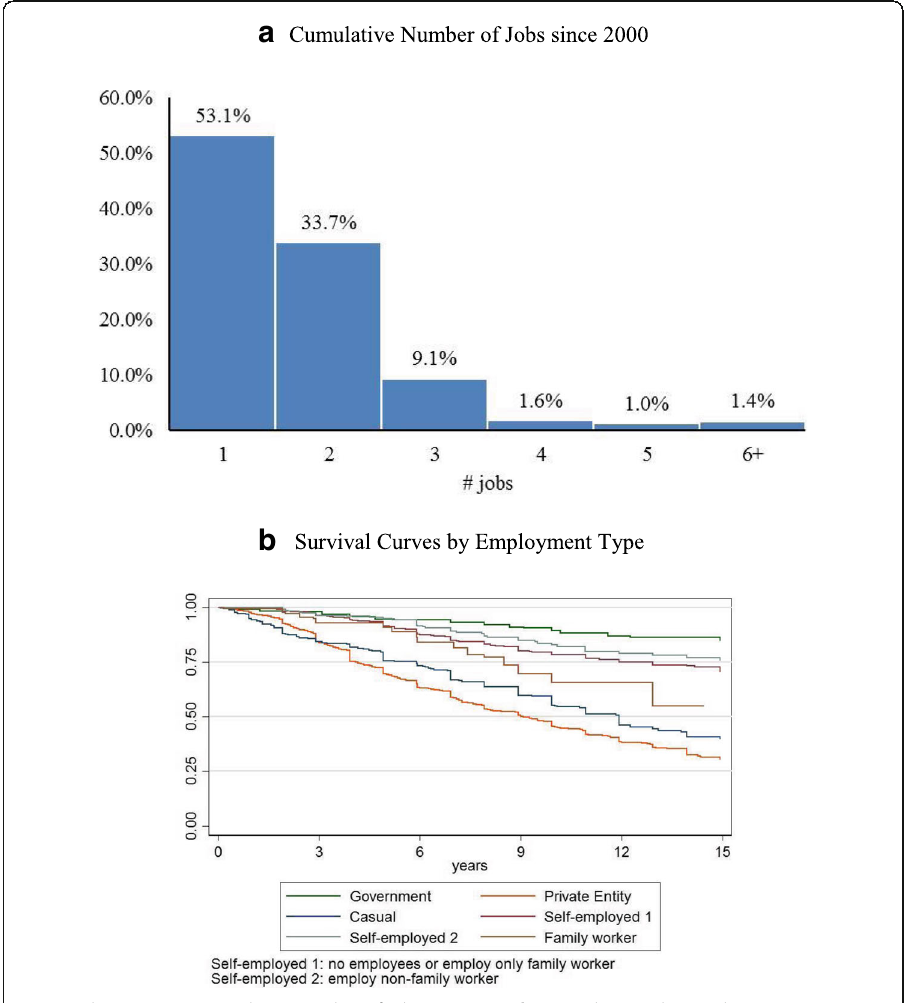
Fig. 2 Job turnover. a Cumulative number of jobs since 2000. b Survival curves by employment